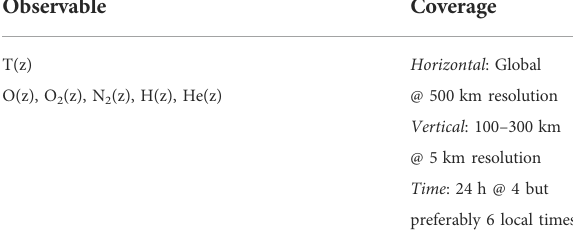
TABLE 1 Key thermospheric composition and temperature observables between 100 and 200